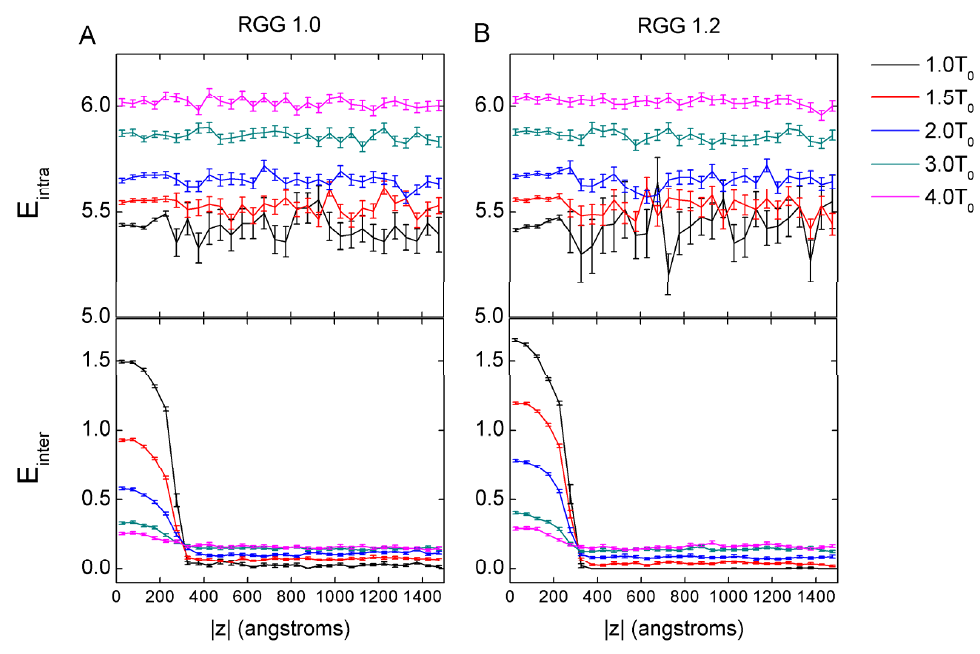
Figure 10. Mean number intra-chain (E intra ) of and inter-chain (E inter ) electrostatic contacts of RGG 1.0 ( A ) and RGG 1.2 ( B ) as a function of |z|. Average and standard error values during the last 1000 τ simulation data are illustrated in this figure.